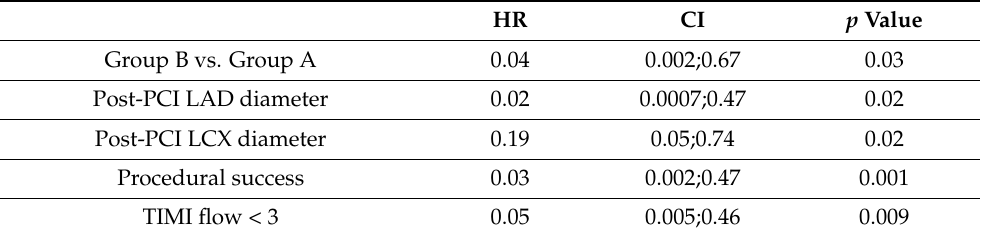
Table 5. Predictors of early death (30 day) adjusted for cardiogenic shock in patients with unprotected left main coronary artery disease and acute coronary syndrome (Group A—one stent strategy; Group B—two stent strategy).